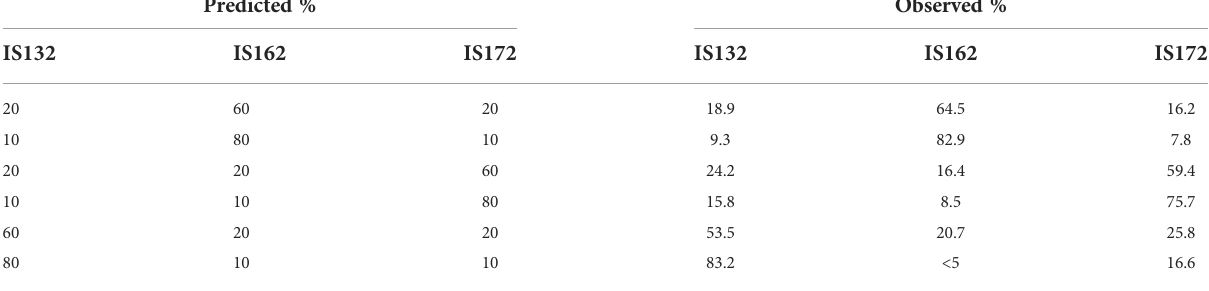
TABLE 5 Summary of the observed versus predicted percentages of each haplotype extracted from the IS132:IS162:IS172 mock communities. Predicted % Observed %